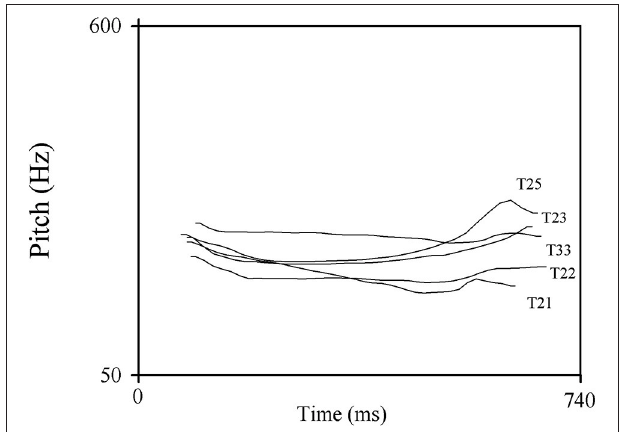
FIGURE 1 | An example of the F0 contours of the syllable /jin/ of the five different tested Cantonese tones.